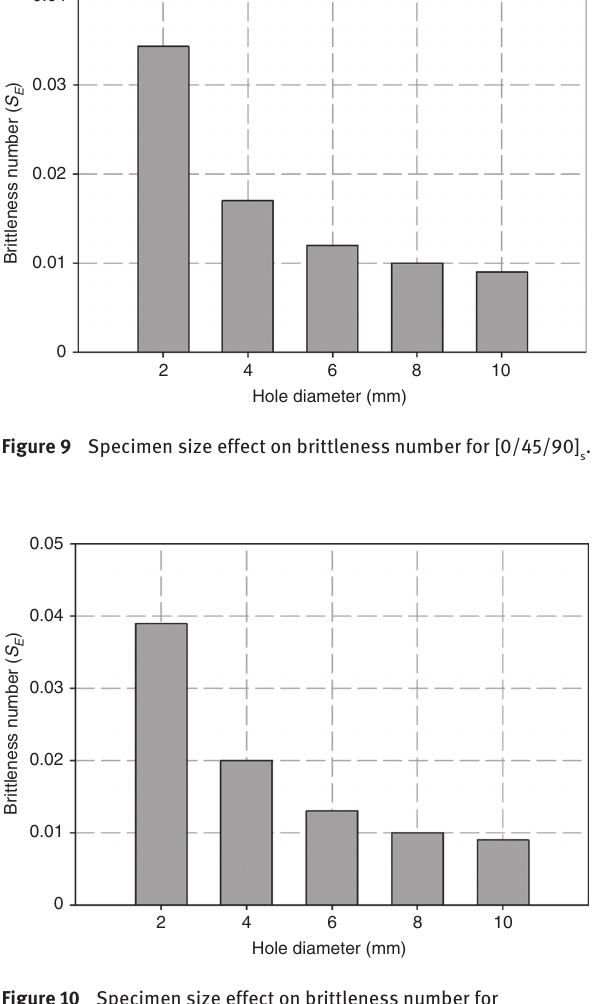
Table 12 Test results for [0/90]